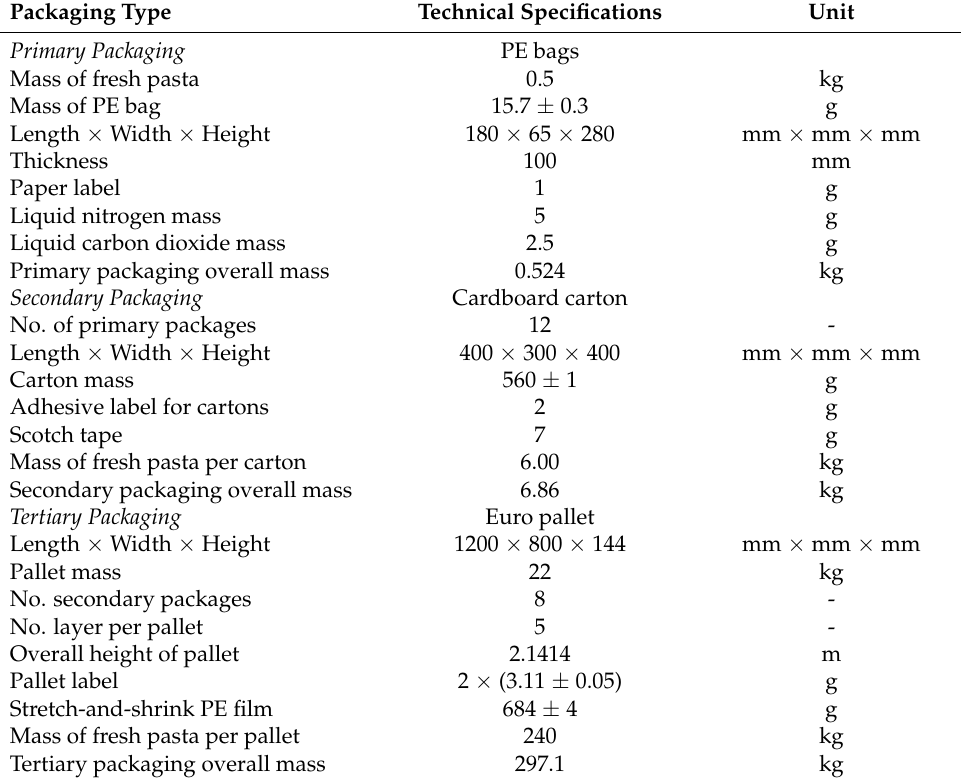
Figure 4. Schematic diagram of the packaging process used for the pasteurized fresh pasta under study. All symbols were listed in the Nomenclature section. Table 3. Fresh pasta packaging: mass of any component of primary, secondary and tertiary packages